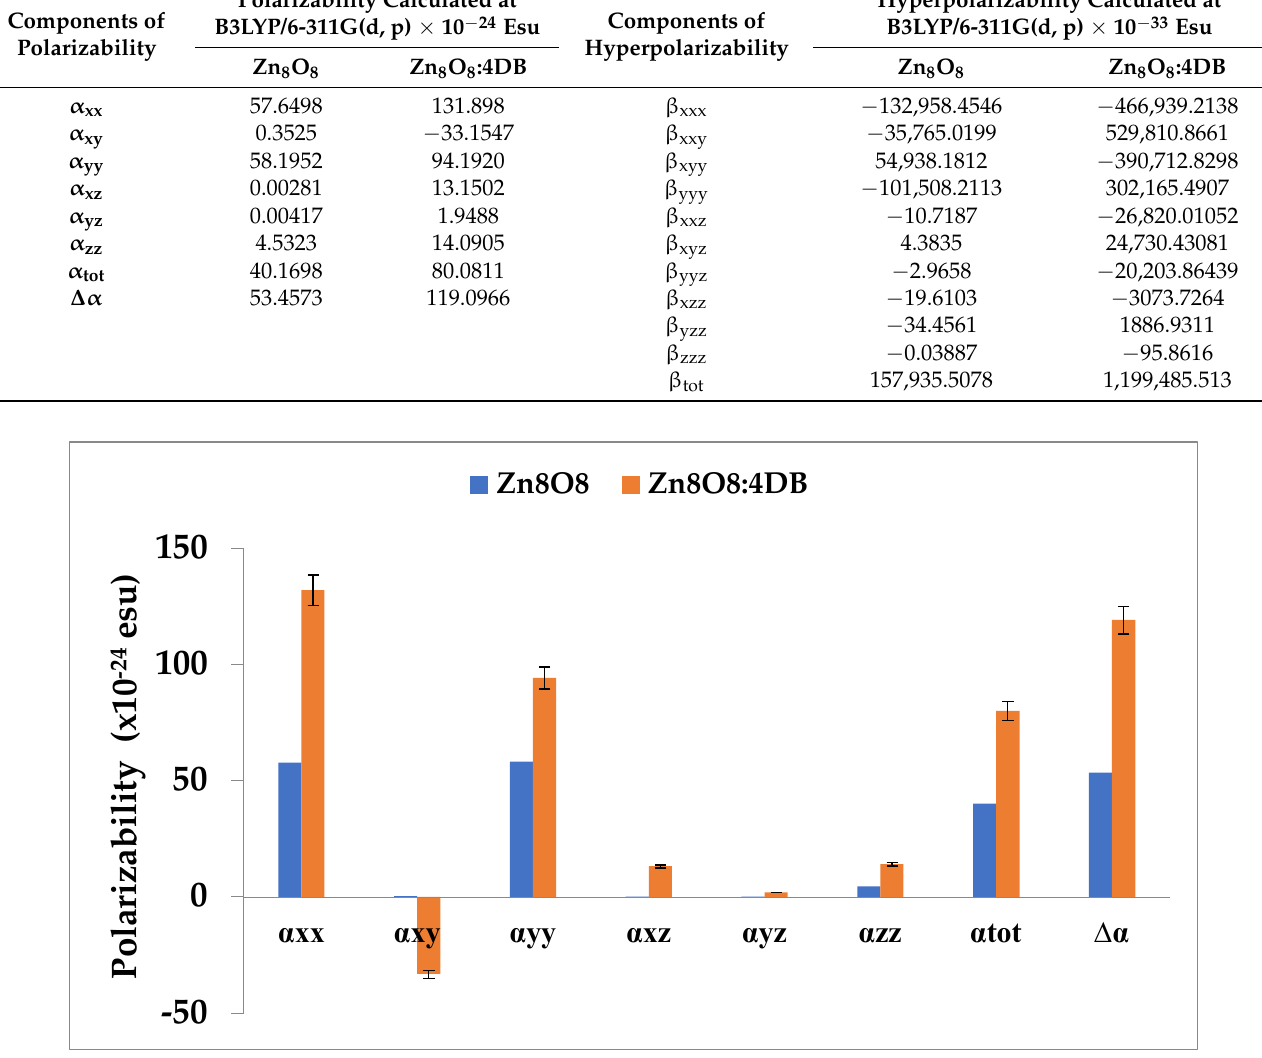
Figure 8. Polarizability and first-order hyperpolarizability of the Zn8O8 and Zn8O8:4DB clusters calculated using B3LYP/6-311 G(d, p).